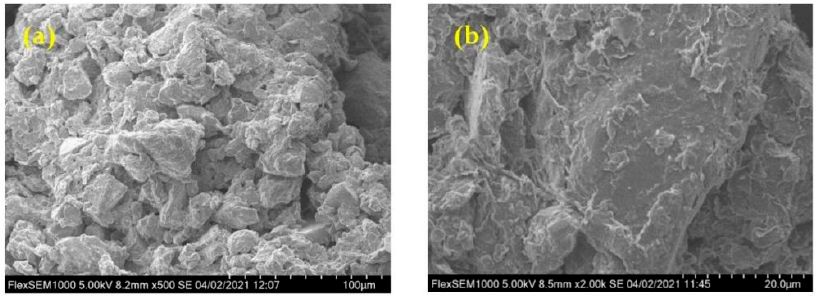
Figure 5. Microstructure characteristics of two soil parent materials: ( a ) RdcPm; ( b ) CPm.